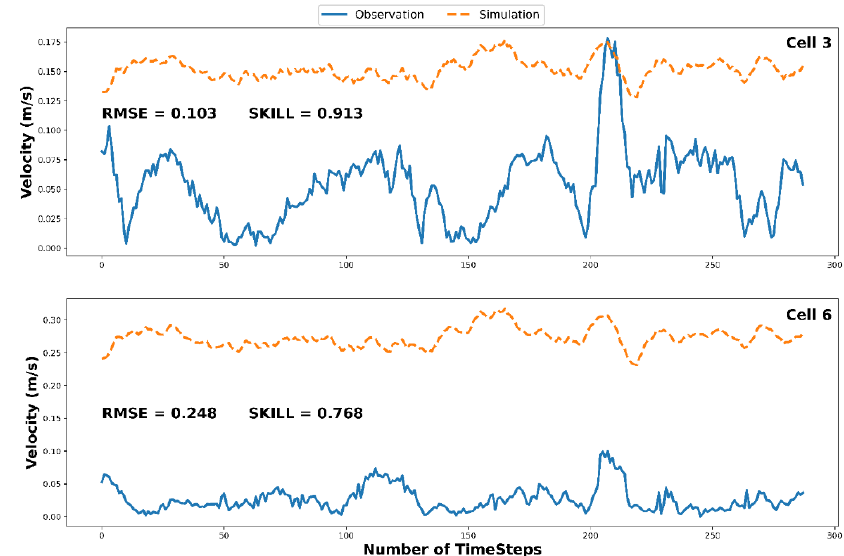
Figure 6. The validation exercise compares the simulated (orange line) and observed (blue line) flow velocity on 6 January 2022.